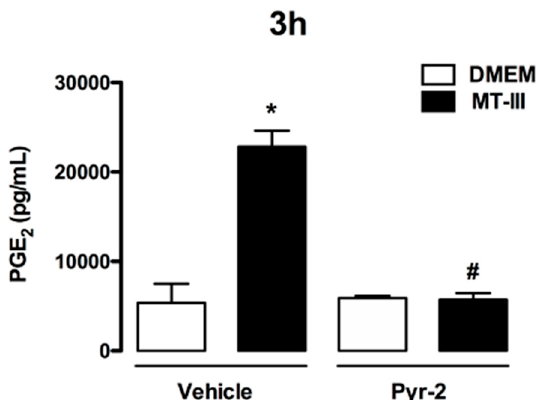
Figure 4. MT-III-induced PGE 2 release is dependent on cPLA2- α in 3T3-L1 preadipocytes. Cells were incubated with Pyr-2 (1 μ M) for 1 h followed by incubation with MT-III (0.4 μ M) for 3 h. PGE 2 concentrations were quantified in culture supernatants by EIA commercial kit. * p < 0.05 as compared with control group and # p < 0.05 as compared with MT-III group (two-way ANOVA and Bonferroni posttest).